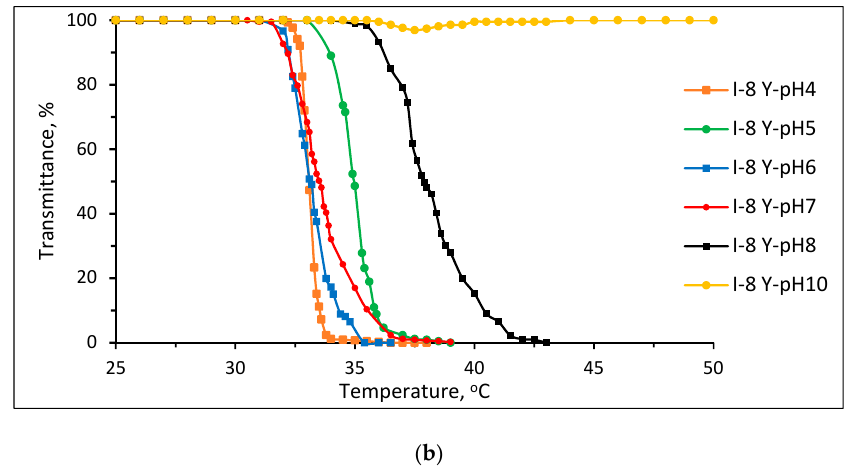
Figure 8. Plots of transmittance vs. temperature of 1 wt % aqueous solutions of P(nipam-co-IAM) (I-8) in buffer solutions of pH = 4~10 ( a ) without and ( b ) with stereo-control. The LCSTs of Pnipam synthesized with and without stereo-control were 30.7 and31.7 °C, respectively, in the pH 4 buffer solution and 29.8 and 30.8 °C, respectively, in the pH 10 buffer solution. The isotactic-rich Pnipam (synthesized with stereo-control) had a lower LCST than the atactic Pnipam (synthesized without stereo-control). The LCST result of the isotactic-rich Pnipam is consistent with the finding from a previous report [19]. Ray et al. [19] reported that the phase separation temperature decreased with an increase in tacticity. Apart from the LCSTs at pH 6 and 7, the LCST of Pnipam without stereo-control showed no pH sensitivity, i.e., the difference of LCSTs was less than ±1. It should be noted that the LCSTs and UCSTs can vary for different pH values, for example, the polymers at pH 6.4, 6.8, 7.4 and 7.8 from table 2 in the report [26]. Figure 9 summarizes